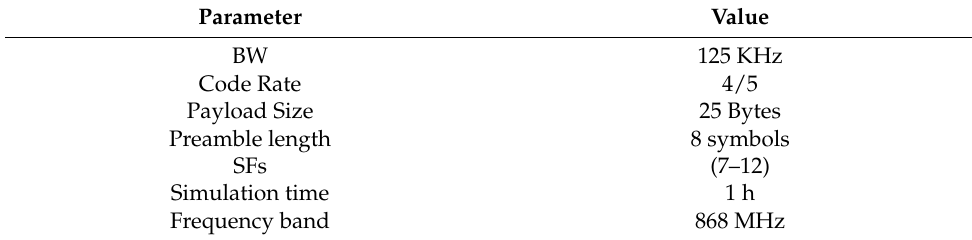
Figure 7. T device scheme. Table 2. Simulation